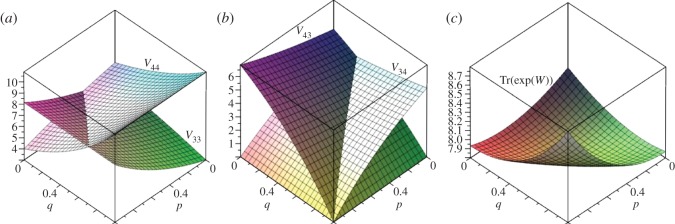
Plots of (a) V33 and V44, (b) V34 and V43, and (c) Tr(eW) for (3,4) partial bipartite graph.